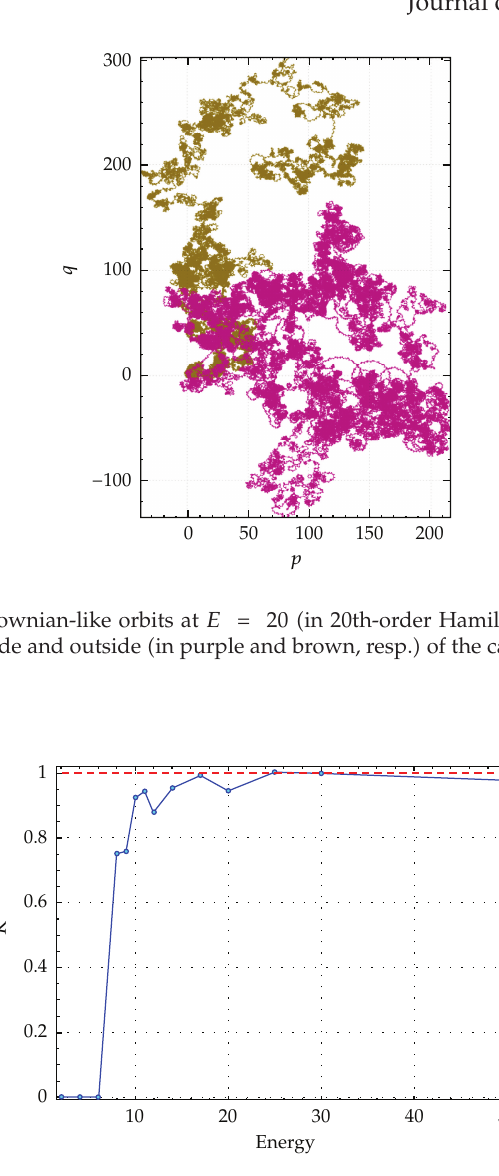
Figure 15: K versus Energy in 20th-order Hamiltonian. The red dashed line is K (cid:7)